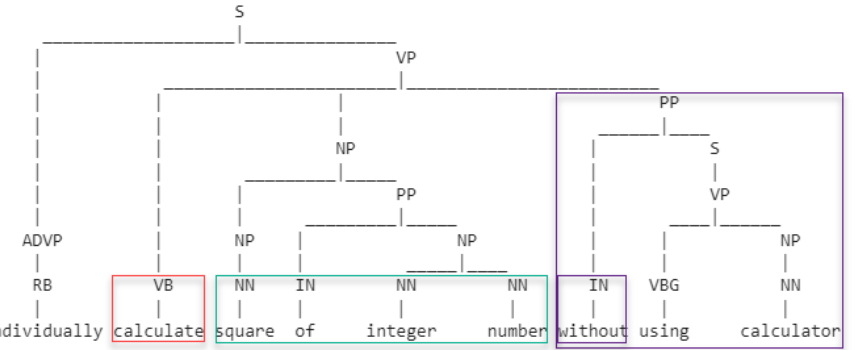
Figure 2. Example of competency text analysis, to get the skill verbs (“calculate” and “applying”) and context, area of the competency (“triangle diagonal” and “Pythagoras theorem”), when joining preposition (“by”) is used.